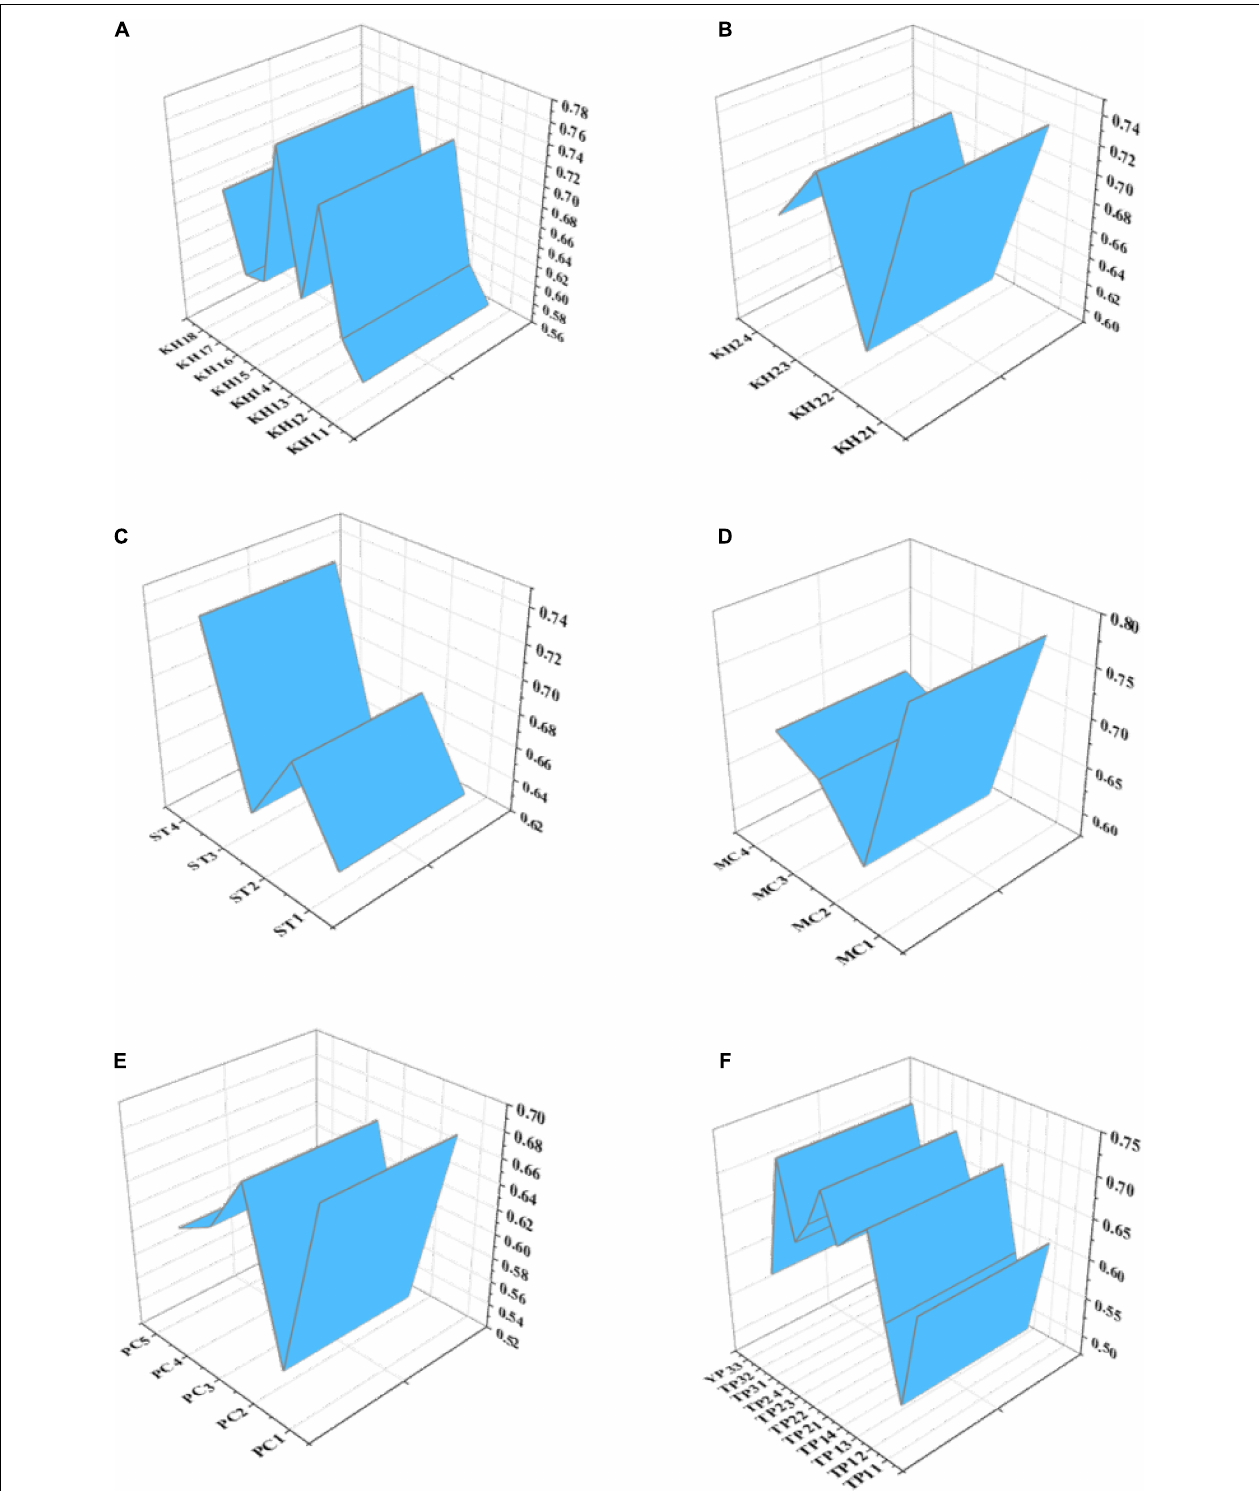
FIGURE 8 | Variable factor load of each topic. (A) Active hiding; (B) Passive hiding; (C) Interpersonal distrust; (D) Control atmosphere; (E) Performance atmosphere; (F) Interim team performance.